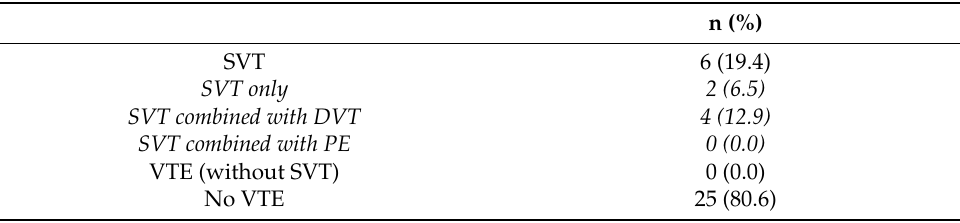
Table 2. Incidence of VTE after TURP (n =